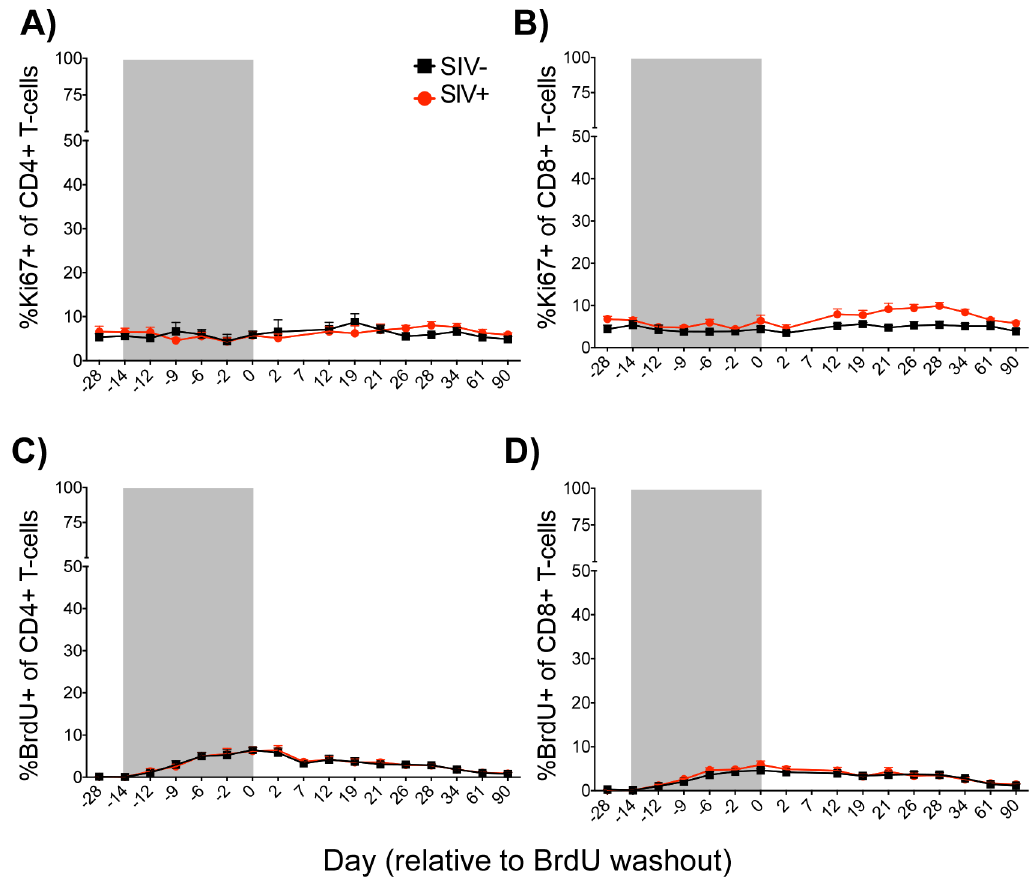
Fig 1. Ki67 and BrdU Expression Among Bulk Peripheral Blood Lymphocytes. The mean ( ± SEM) percent Ki67+ (A+B) and percent BrdU+ (C+D) of peripheral blood CD4+ (A+C) and CD8+ (B+D) T-cells were assessed longitudinally by flow cytometry in both uninfected (black squares) and infected (red circles) animals. p = NS between infected and uninfected controls at all timepoints for all populations (Mann-Whitney U). Shaded area represents BrdU administration period. Data points are shown only for animals above which 100 events were collected for the parent